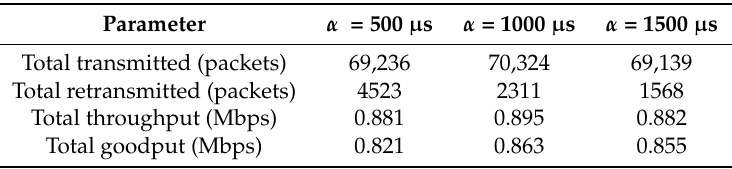
Table 3. Performance of BBR-ACD for different values of α